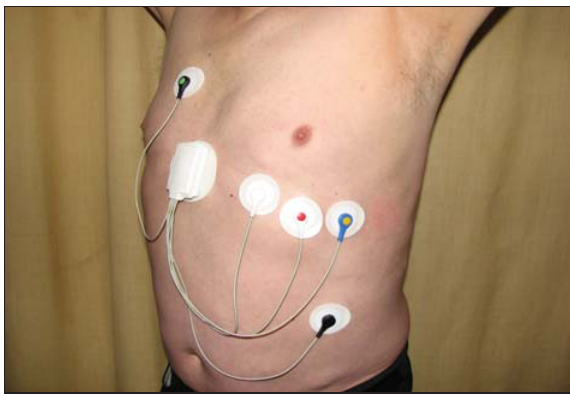
Figure 2. The developed system for registration the signals of 3 ECG leads and 3-axis accelerometer (inside of